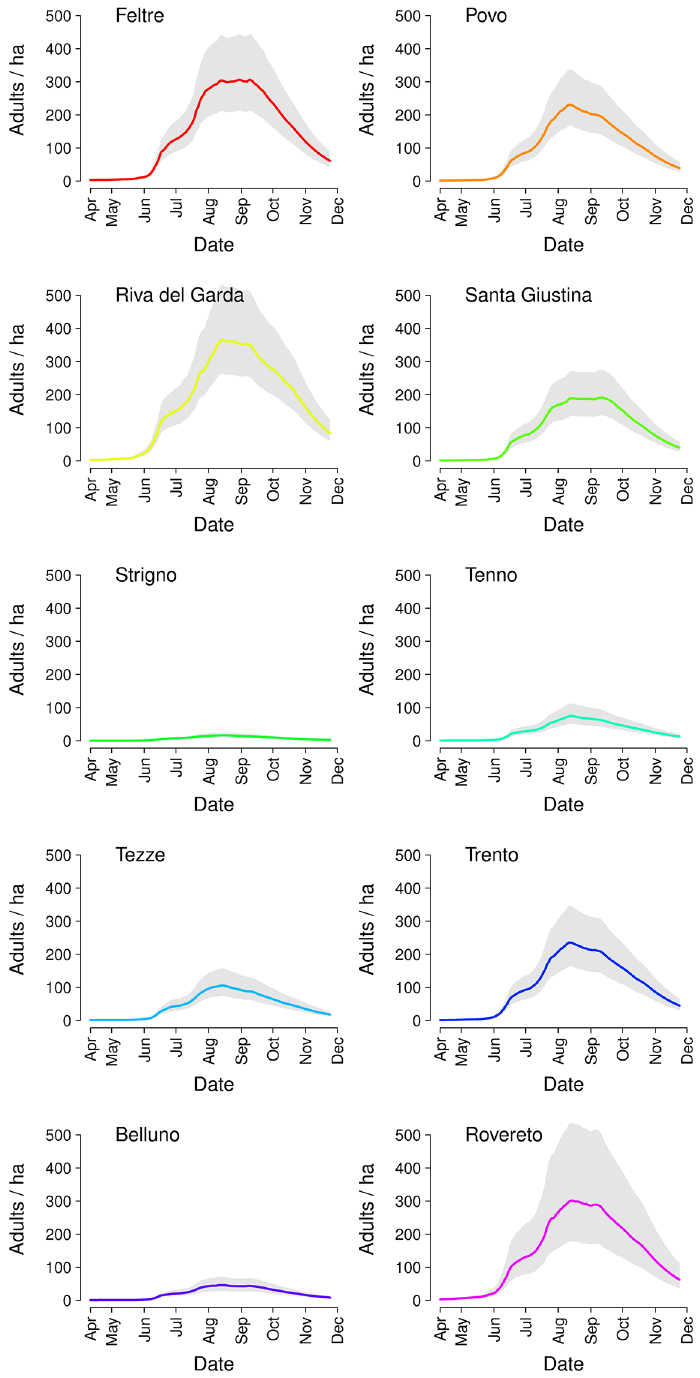
Fig 2. Model estimates for densities of adult females by study site; grey bars represent 95% CI calculated over 200 samples of the posterior distribution of parameters and 50 stochastic iterations.